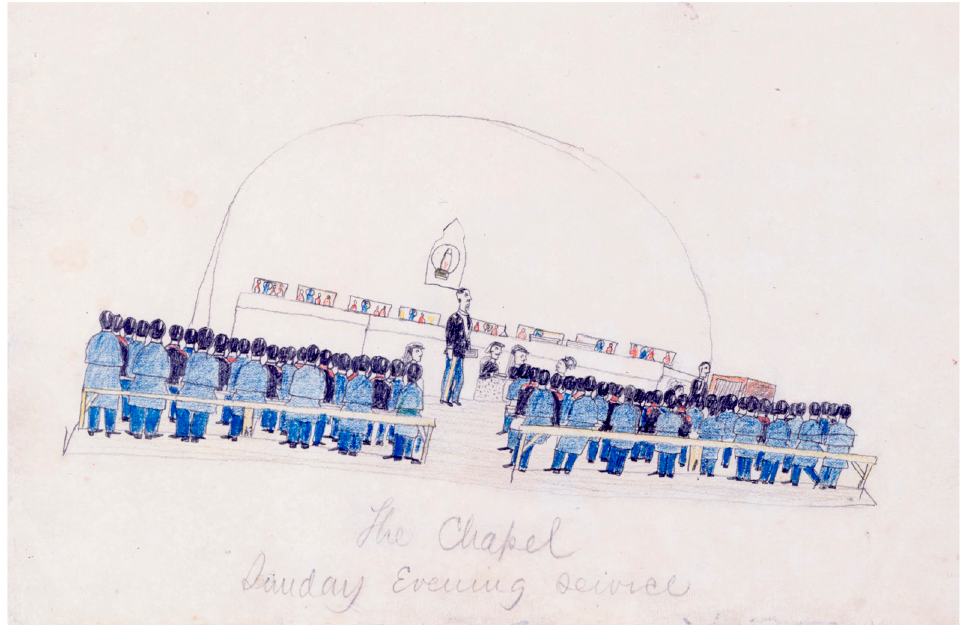
Fig ure 9. Zó ̱ ta ̂ m’s (Driftwood) drawing of required chapel services at Fort Marion. Inmates listened